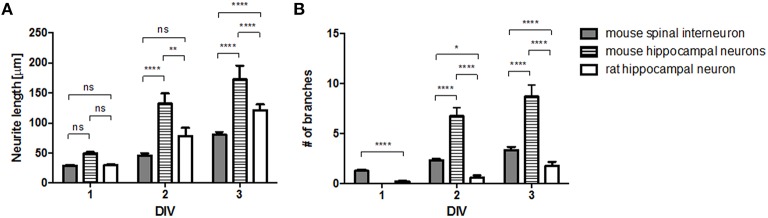
Cell-type specific growth on no-pattern (control) substrates. Neurite length (A) and branch number (B) of mouse spinal interneuron, mouse hippocampal neurons, and rat hippocampal neurons on control substrates (mean ± SEM; *p < 0.05, **p < 0.01, ****p < 0.0001 by two-way ANOVA with Bonferroni's multiple comparison test).